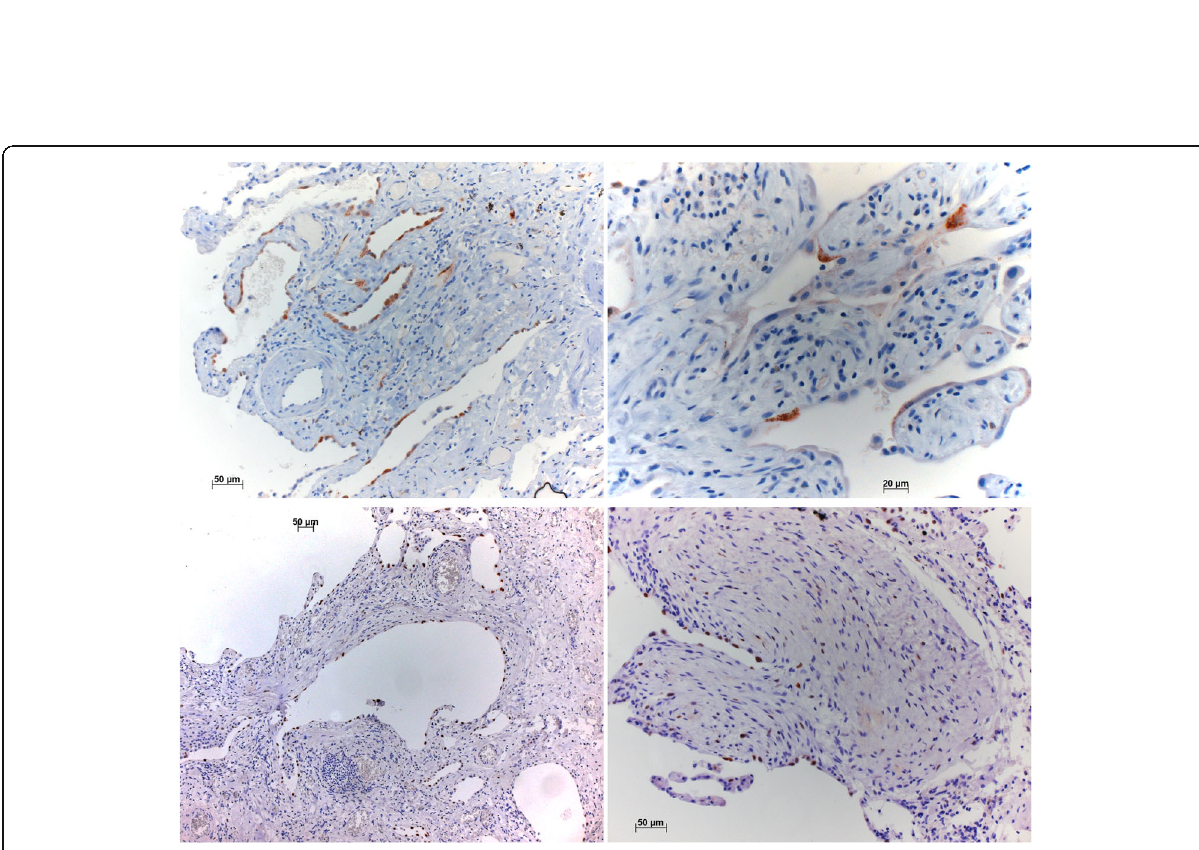
Fig. 7 Senescence in IPF, in the upper figures the senescent cells are stained by p16 (cytoplasmic), in the lower figures the cells are stained by p21 (nuclear). Both are surrogate markers for senescent cells. Bars 50 and 20 μ m,